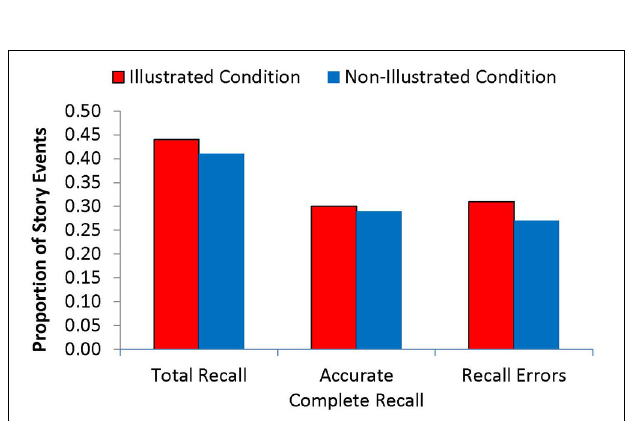
FIGURE 3 | Recall performance at the 1-week interview, by story-reading condition.